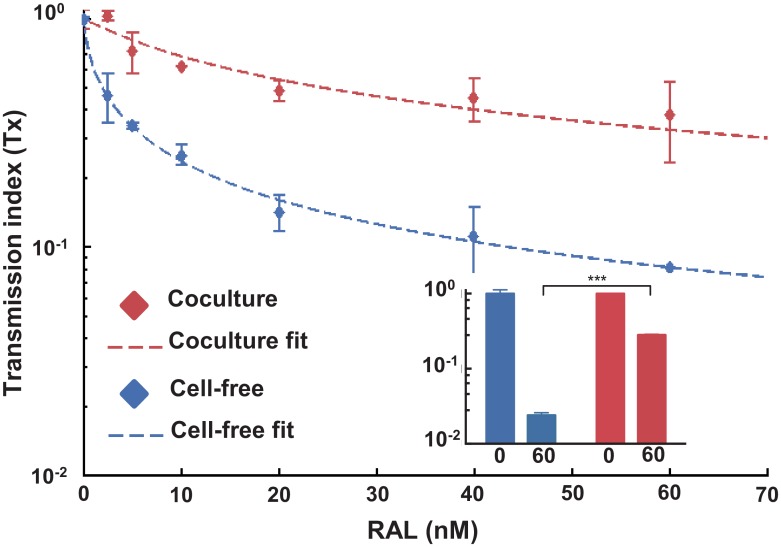
Decreased sensitivity of coculture HIV spread to RAL predicts multiple infections per cell.Sensitivity of coculture (red) and cell-free (blue) infection to the integrase inhibitor raltegravir (RAL) in PBMCs. Points are means and standard errors of duplicates from one of three experiments with different blood donors. Transmission index (Tx) was calculated as the number of infected target cells with RAL divided by the number of infected target cells without RAL. Blue dashed line represents parametrization of the cell-free infection response to RAL in terms of IC50 (1.9 nM) and hill coefficient (0.7). Red dashed line represents the fit of coculture infection using the decreased sensitivity to RAL (Materials and methods). An effective MOI of 4.8 is predicted for coculture infection. Inset: Sensitivity of primary CD4+ T cell infection to RAL. Points are Tx means and standard errors of duplicates from one of three experiments with different blood donors. The drug sensitivity differences in CD4+ T cells between cell-free and coculture was statistically significant (p < 0.001, two-tailed unpaired t-test).